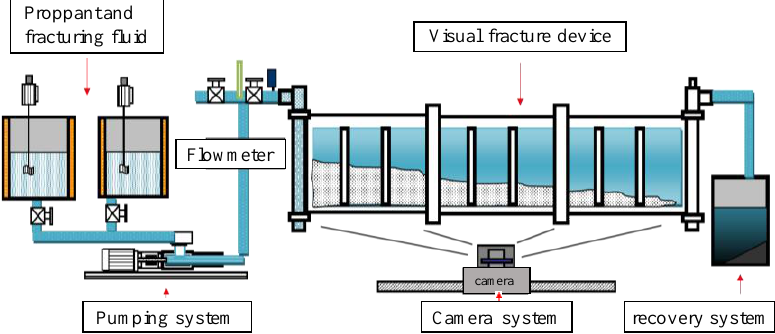
Figure 2. Experimental device schematic. The device consists of six parts: the proppant and fracturing fluid, pumping system, flowmeter, visual fracture device, camera system, and recovery system.